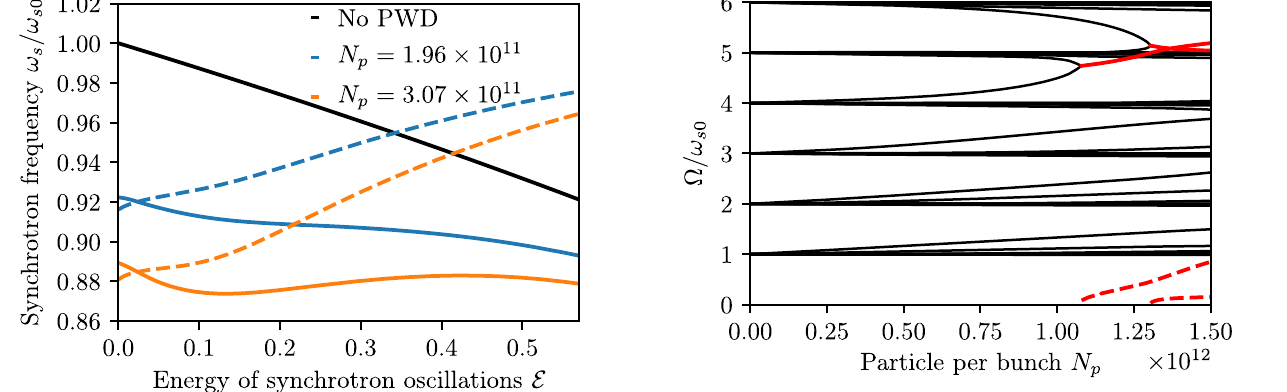
PWD.FIG. 5. Synchrotron frequency as a function of synchrotron- oscillation energy for different intensities and E lines are for single-rf potential, while dashed lines are for a parabolic-rf potential. The black curve illustrates the case without PWD.